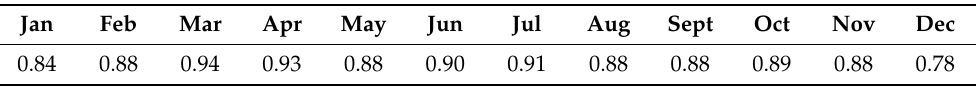
Table 3. Pearson correlation coefficients between tropospheric NO 2 column and surface concentra- tions for 2011.